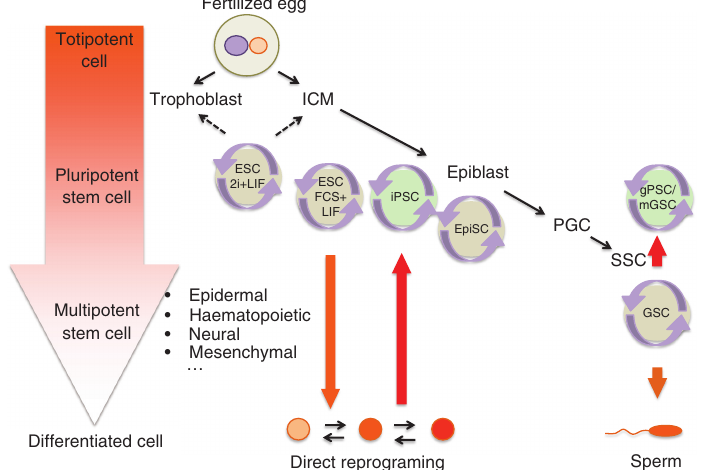
Figure 1 Schematic showing stem cell derivation from various cell types and developmental stages. Pluripotent stem cells are generated from early embryos (ESCs and EpiSCs) and differentiated cells (iPSCs) and can give rise to three germ layers (ectoderm, mesoderm, and endoderm). gPSCs and mGSCs generated from testis also show ESC-like pluripotent properties (50, 51). Most tissue-specific stem cells found in adult tissues, including epidermal, haematopoietic, neural and mesenchymal stem cells, are already committed to one lineage and exhibit multi-potential. Meanwhile, GSCs can only give rise to sperm and therefore are monopotent. Direct reprogramming renders one differentiated cell population from another through the induction of transcription factors and micro RNAs (see text for